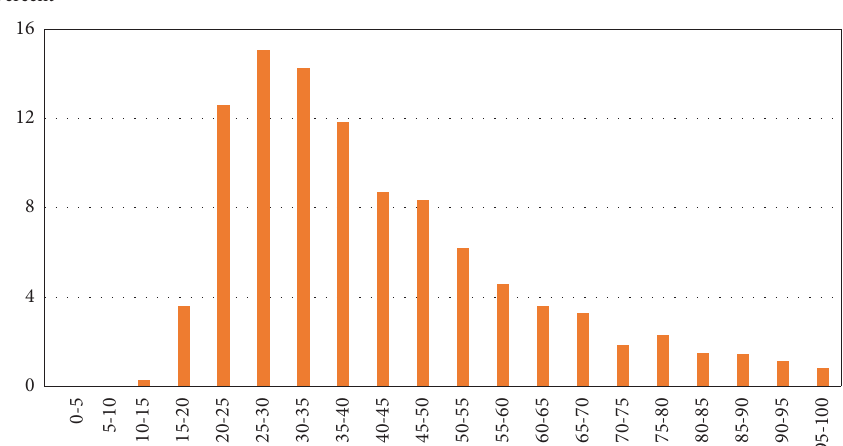
Figure 1: Loss of investment and construction efciency caused by fnancing constraints.